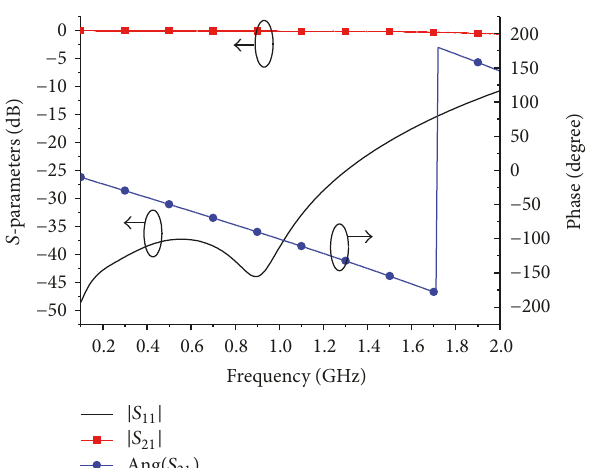
Figure 8: Simulated 𝑠 -parameters of proposed 158.1 Ω transmission line.